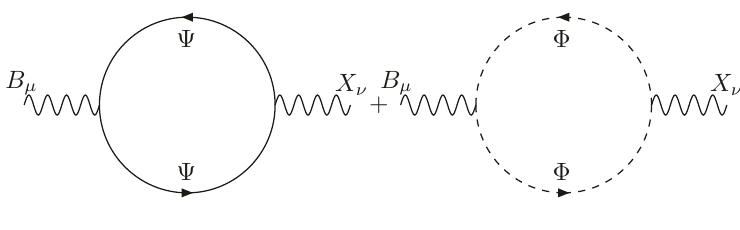
Figure 4. The 1-loop corrections of the B µν X µν